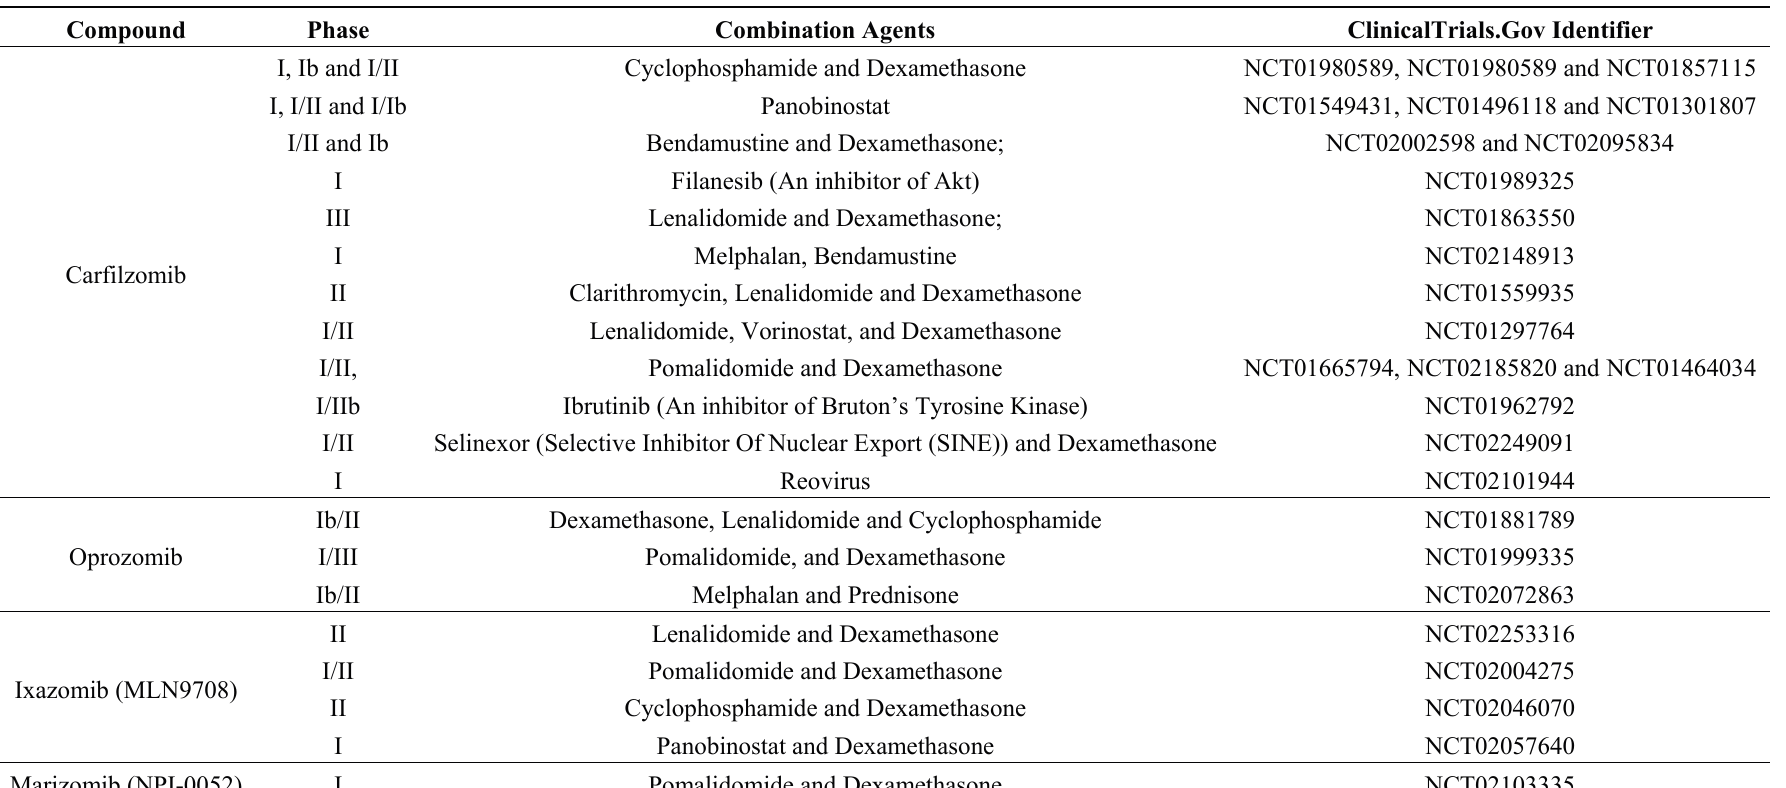
Table 2. Selected clinical trials combining other agents with second generation proteosome inhibitors in multiple